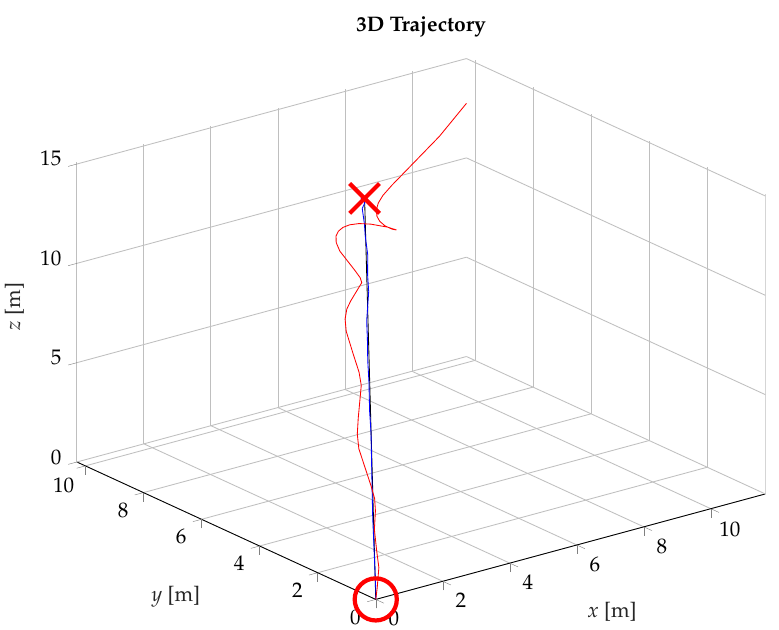
Figure 10. 3D drone trajectory: reference (black), robust control (blue), and non-robust control (red). Figure 10. Three-dimensional (3D) drone trajectory: reference (black), robust control (blue), and non- The green circle and the green cross indicate respectively the starting and ending point of 3D reference robust control (red). The red circle and the red cross indicate, respectively, the starting and ending trajectory. point of 3D reference